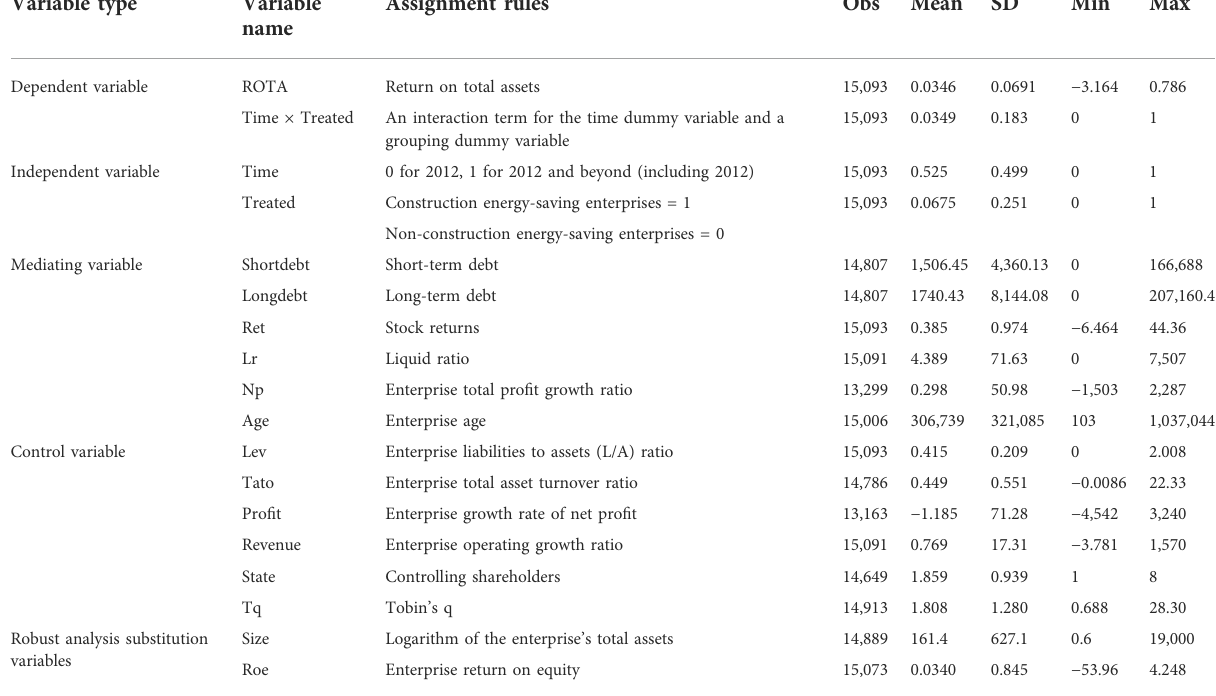
TABLE 1 Variable setting and descriptive